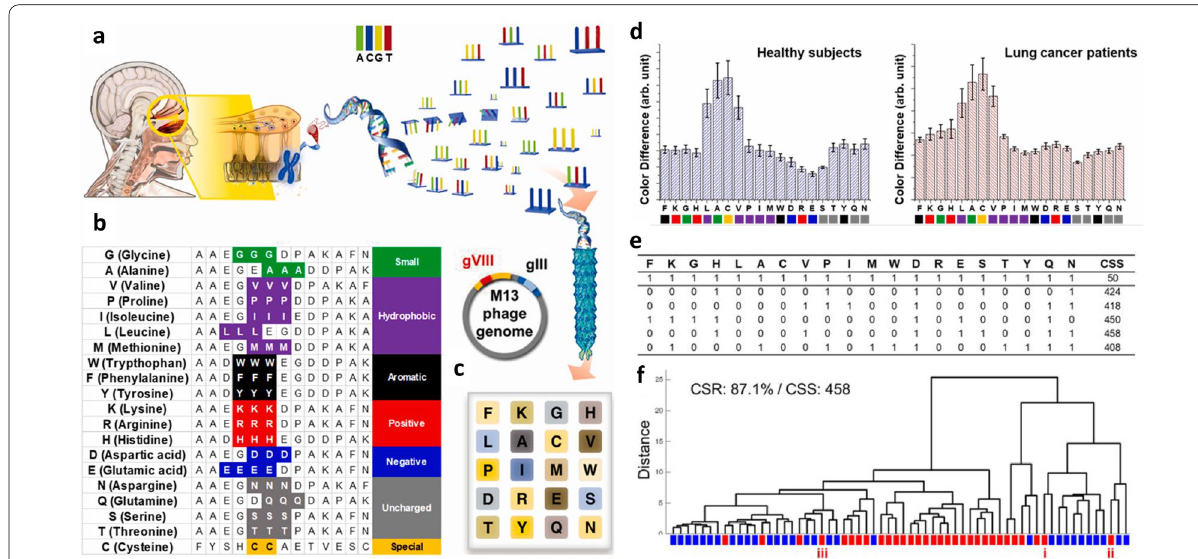
Fig. 9 Schematic diagram of the DNA‑derived electronic nose. a A sequence of 20 amino acids associated with DNA serving as a blueprint for mammalian olfactory receptor cells. Each selected DNA sequence was implanted into a M13 bacteriophage using genetic engineering methods. b Sequence listing of genetically engineered M13 bacteriophage. c Arrangement of the phage film. d Mean colour distance measured by respiration of 31 healthy subjects (left) and 31 patients (right). e classification success scores (CSS) histograms calculated for all possible combinations of 20 films. f HCA dendrograms based on the best multi‑array colourimetric sensor combination selected via neural pattern separation (NPS). Labels i, ii, and iii represent patients with tumours all in the upper lobe and peripheral lesions ( a – f Adapted from Ref.